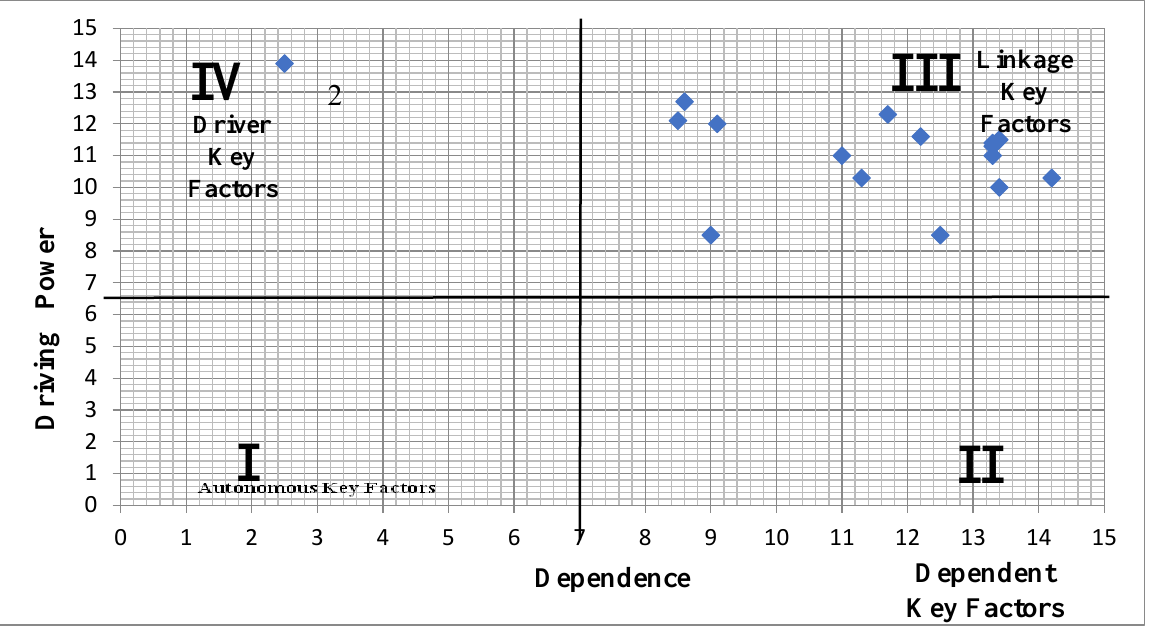
Figure 4. FUZZY MICMAC on the DEP and DRP of factors.